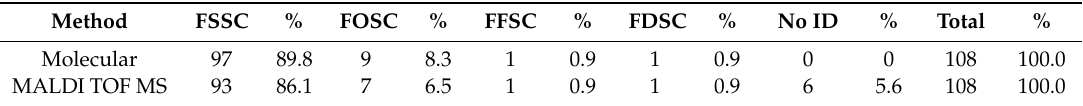
Table 1. Molecular method (ITS and EF-1 α sequencing) and MALDI-TOF MS identification of the 108 Fusarium spp. clinical